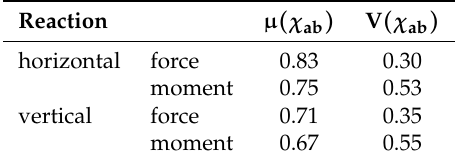
Table 3. Mean ( µ ) and coefficient of variation (V) of the model uncertainties in Goda’s original wave load formula as established by Meer et al. [46]. Model uncertainty defined by Equation